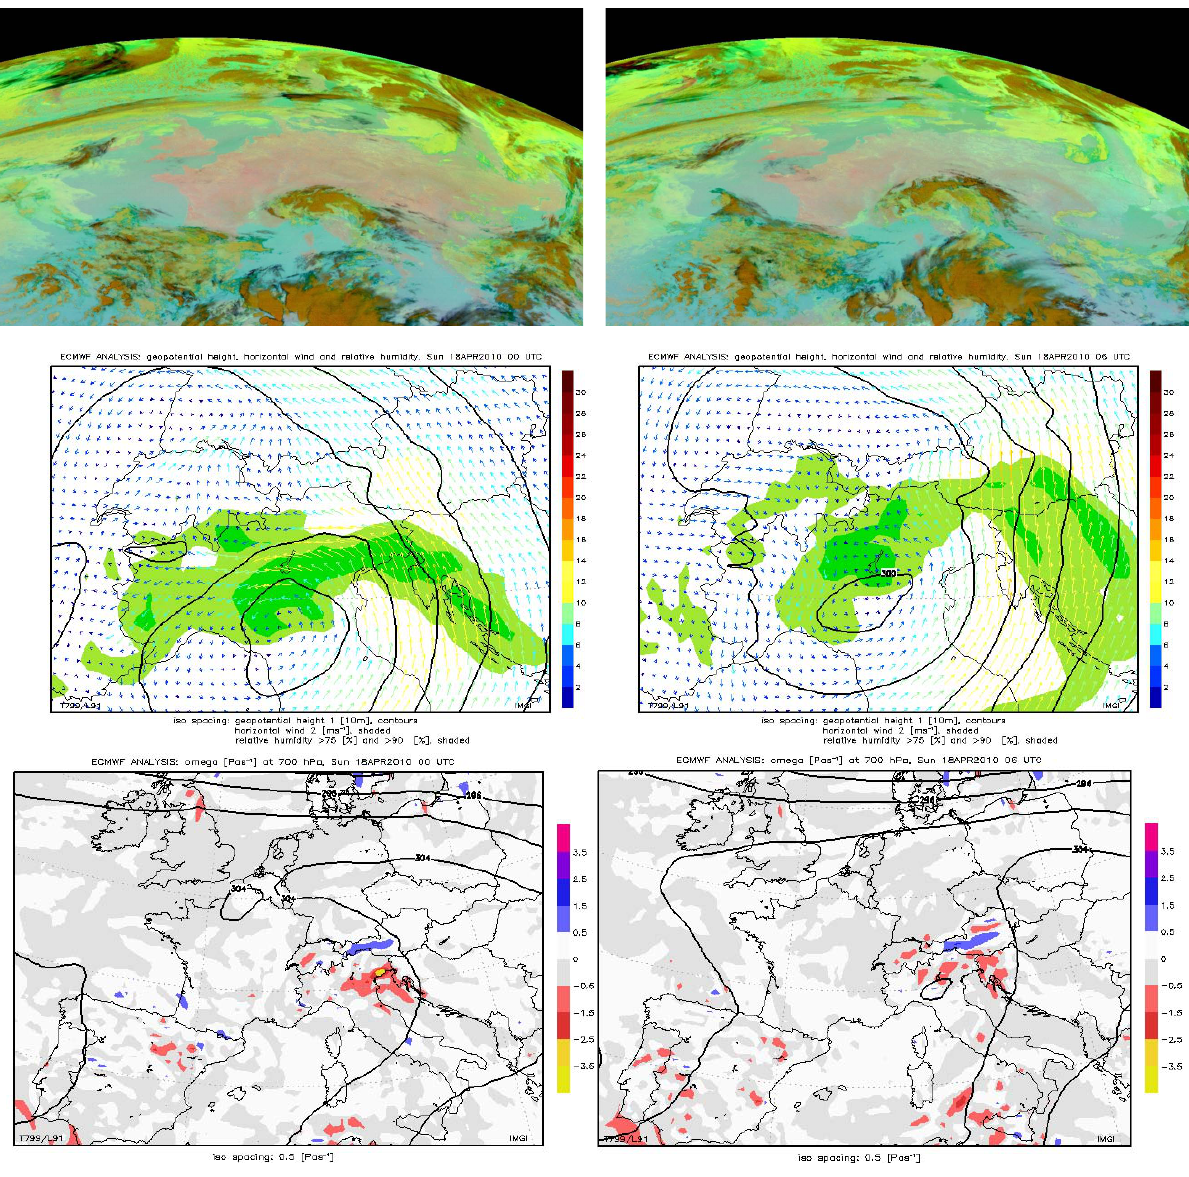
Fig. 4. Upper panels: METEOSAT SEVIRI “ash product” from 18 April, 00:00 UTC (left) and 18 April, 06:00UTC (right). High cloudiness (brownish) is apparent south of the Alps allocated to a cyclonic system over the Gulf of Genoa (see also Fig. 3). Middle panels: 700 hPa geopotential height (10 gpm contour lines), relative humidity ( > 90% in dark green) and horizontal wind (speed and direction, colour coded arrows in 2ms − 1 steps) taken from ECMWF analyses. Lower panels: 700 hPa geopotential height (40gpm contour lines) and vertical wind components (colour coded in steps of 0.5Pas − 1 )